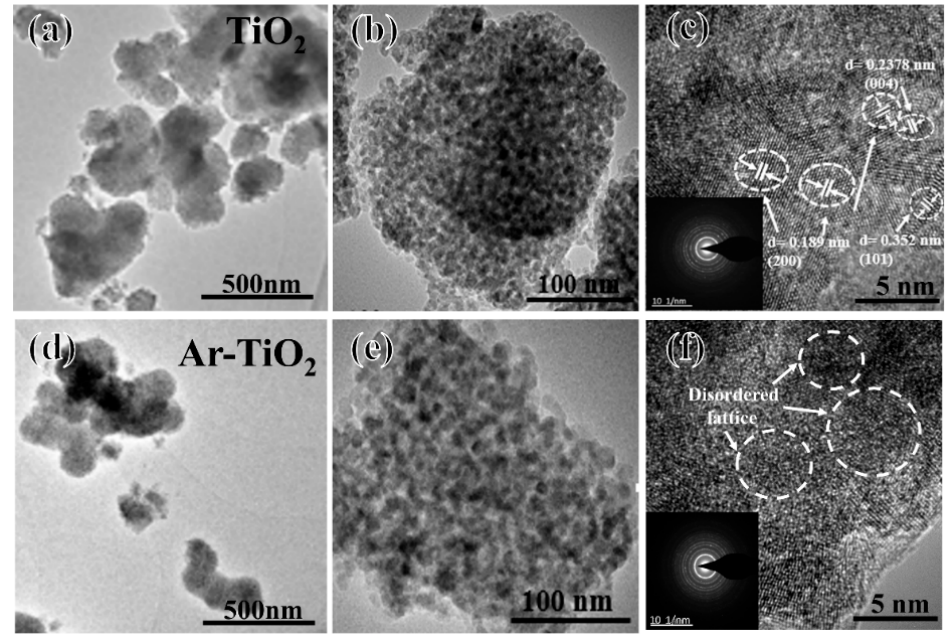
Figure 5. The results of transmission electron microscopy (TEM) of ( a , b ) TiO 2 and ( d , e ) Ar-TiO 2 . High resolution TEM (HRTEM) image curves of ( c ) TiO 2 (inset: SAED) and ( f ) Ar-TiO 2 (insert: SAED).